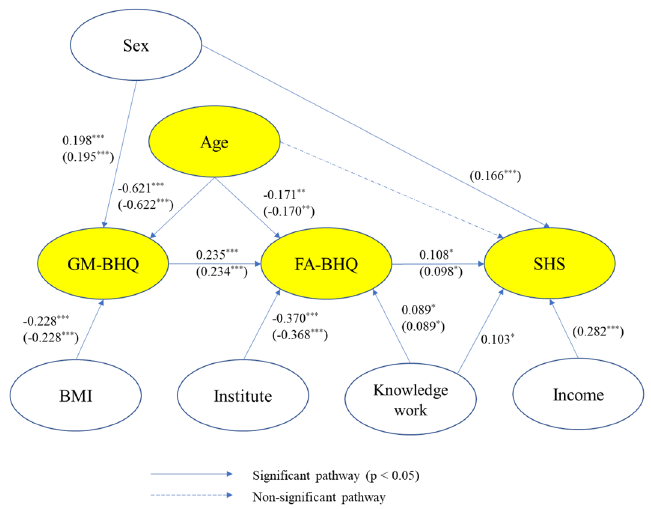
Figure 3. Path diagram for the resulting association between age, SHS, the GM-BHQ, and the FA-BHQ. Goodness-of-fit indices: χ 2 = 9.606 (17.885); df = 12 (17); root mean square error of approximation (RMSEA) = 0.000 (0.011); probability of close fit (PCLOSE) = 0.982 (0.970); goodness of fit index (GFI) = 0.994 (0.991); adjusted goodness of fit index (AGFI) = 0.983 (0.975); normed fit index (NFI) = 0.986 (0.981); comparative fit index (CFI) = 1.000 (0.999). n = 417; *p < 0.05; **p < 0.01; ***p < 0.001. The figures are controlled for sex, BMI, knowledge work, and institute. The numbers in parentheses are the ones when income is added to the control. Error terms and correlations between variables are omitted in the figure. The yellow variables are the main variables.